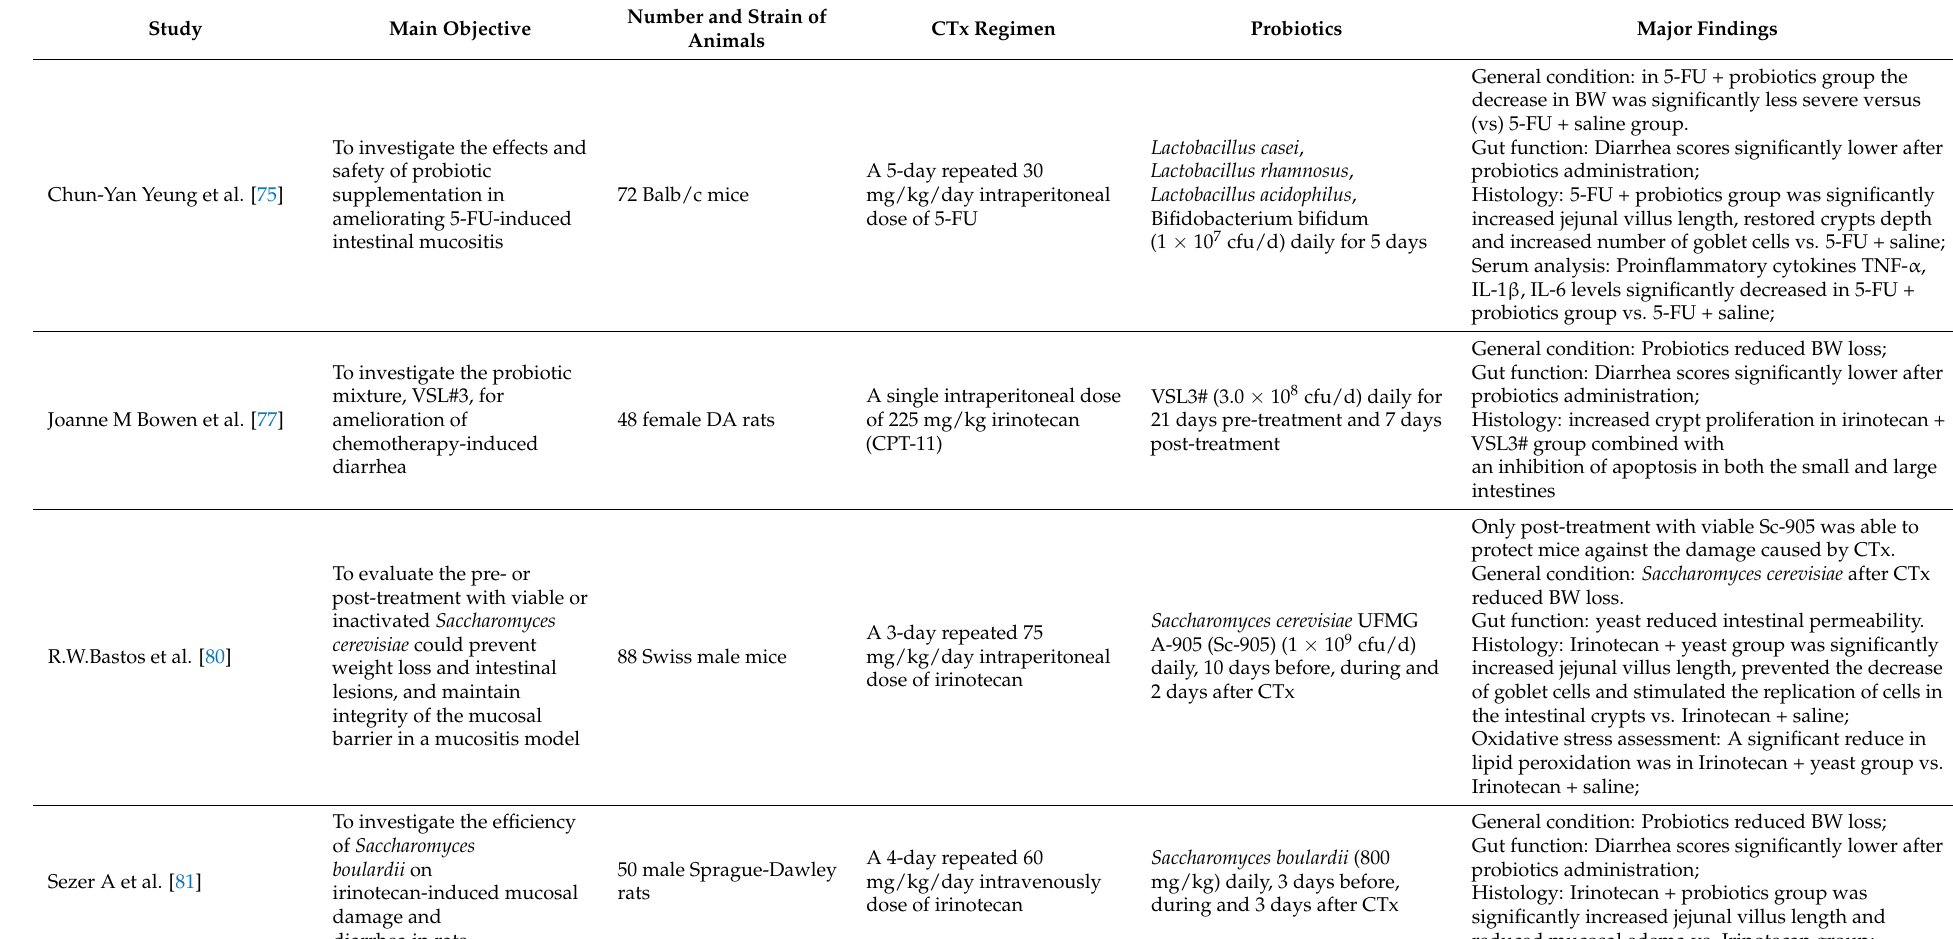
Table 2. Studies conducted on probiotic role in treating and prevention the side effect of CRC treatments in animal